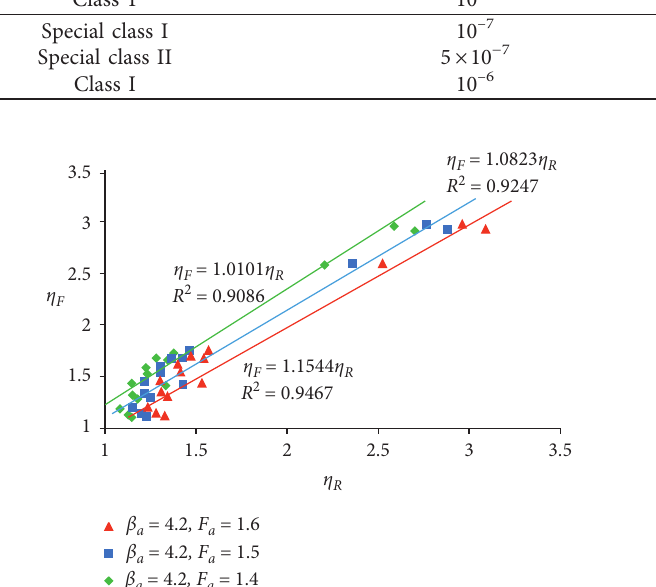
Figure 7: The correlation of η slopes).